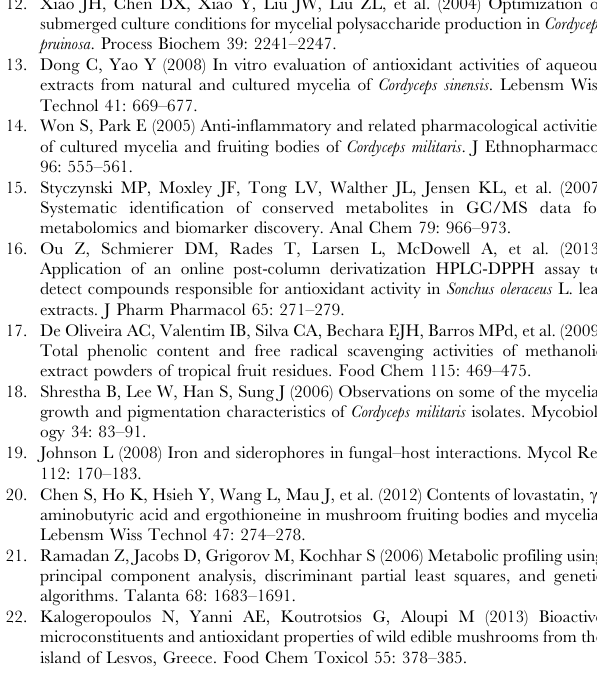
Figure S3 PCA loading plots derived from GC-MS analysis of 70% methanol extracts of C. pruinosa mycelia cultivated under various conditions. (TIF) Figure S4 PCA loading plots derived from GC-MS analysis of 100% n -hexane extracts of C. pruinosa mycelia cultivated under various conditions. (TIF) Figure S5 PLS t 1 /u 1 score plots representing relation- ship between the free radical scavenging activities (u 1 ) and metabolic profiles (t 1 ) obtained by NMR and GC- MS. (TIF) Table S1 A GC-MS-based metabolic profile of 70% methanol extracts of C. pruinosa mycelia. The relative levels of each metabolite were obtained by dividing the percentage area of each metabolite by the percentage area of the internal standard. Different letters in the same row indicate a significant difference. Mean 6 SD values for triplicate measurements are shown. ‘ND’ means ‘not detected’. (DOCX) Table S2 A GC-MS-based metabolic profile of 100% n- hexane extracts of C. pruinosa mycelia. The relative levels of each metabolite were obtained by dividing the percentage area of each metabolite by the percentage area of the internal standard. Different letters in the same row indicate a significant difference. Mean 6 SD values for triplicate measurements are shown. ‘ND’ means ‘not